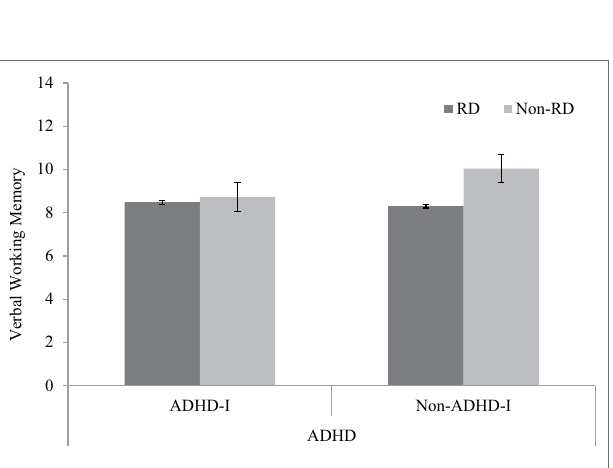
FIGURE 2 | Interaction effect of ADHD-I and RD in verbal working memory.